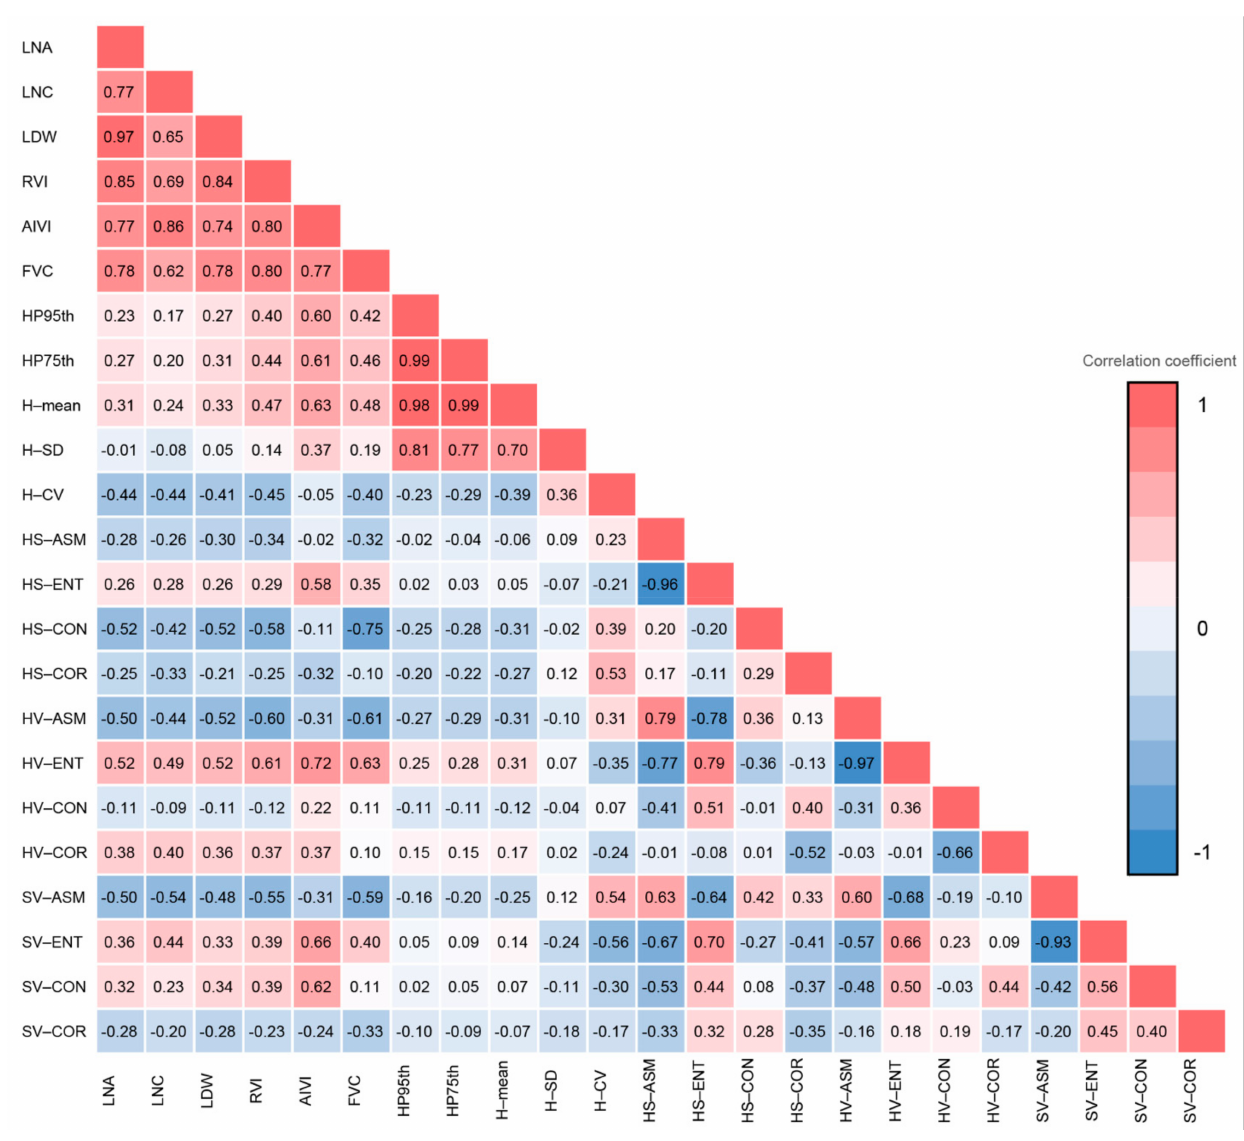
Figure 6. Thermodynamic diagram of correlation between the nitrogen index, vegetation index and canopy structural